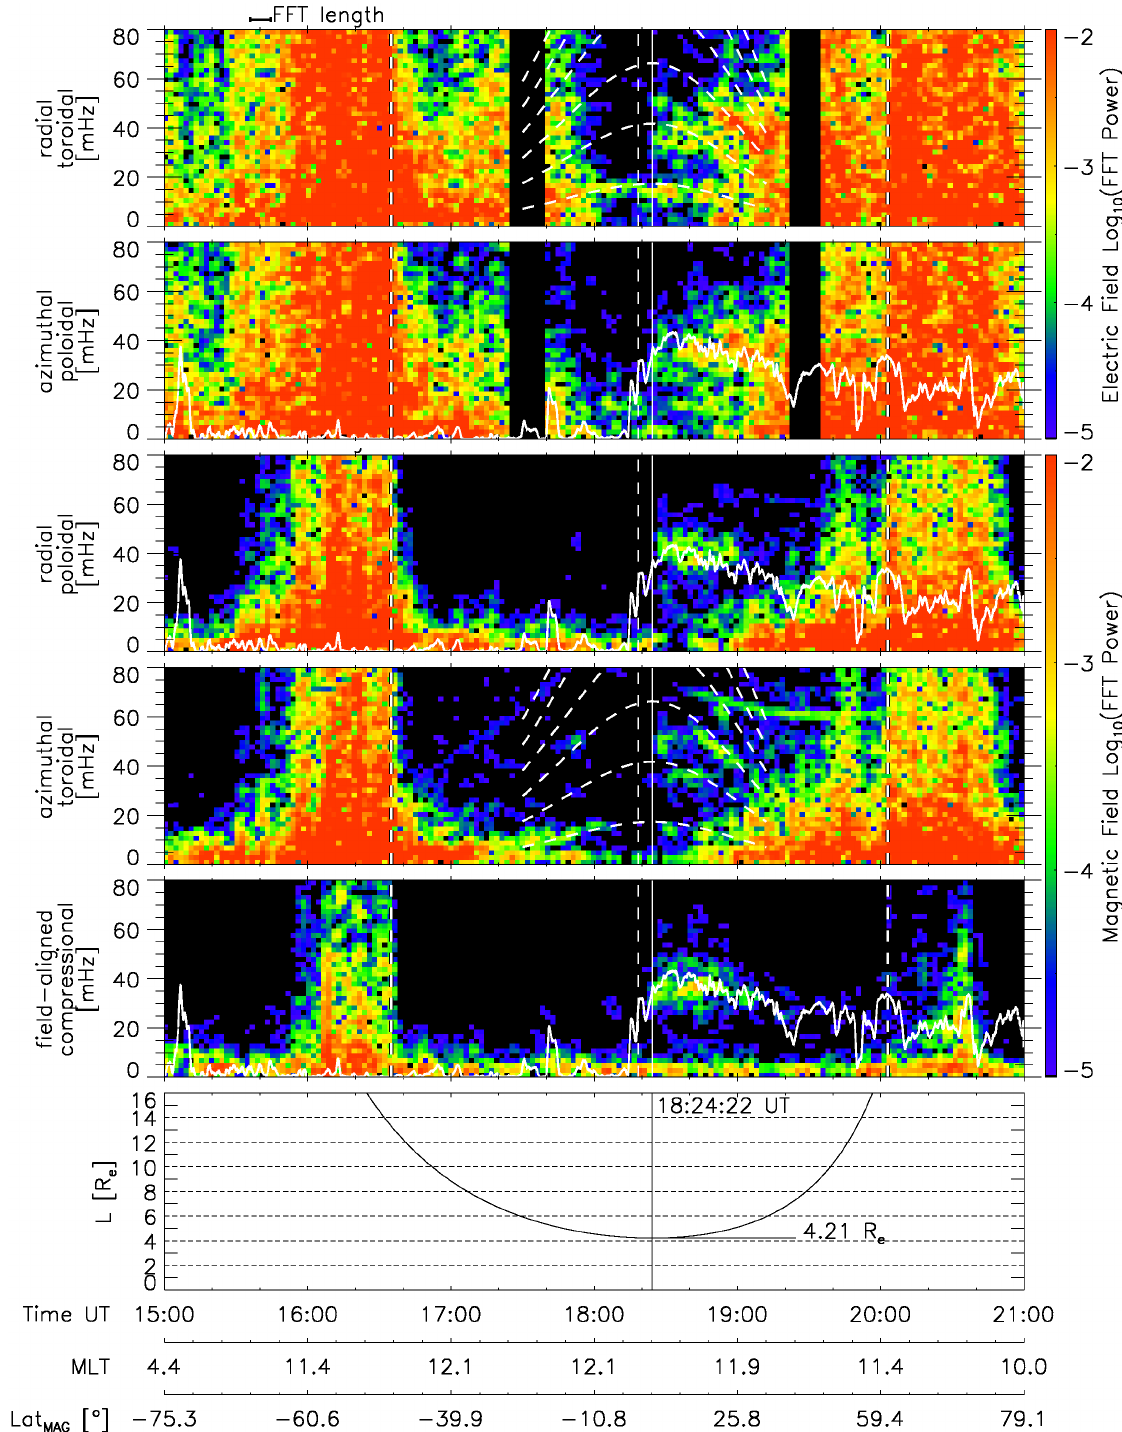
Fig. 7. Same format as Fig. 4, but s/c 4 data on 05 September 2002.